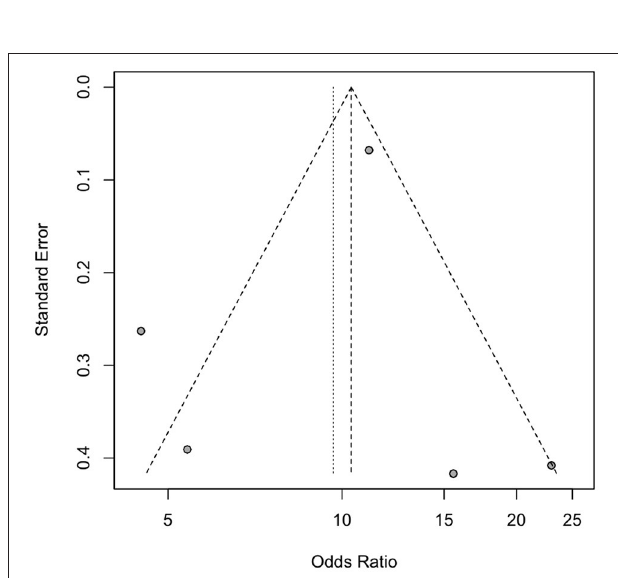
FIGURE 4 | The funnel plot assesses publication bias in the included